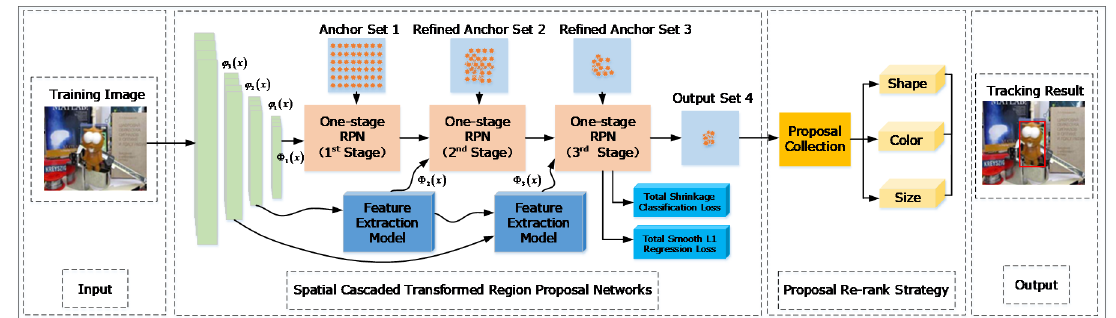
Figure 2. Flow diagram of the proposed tracking algorithm. The improvements which should be noticed are the feature extraction model, shrinkage classification loss, and proposal re-ranking strategy.